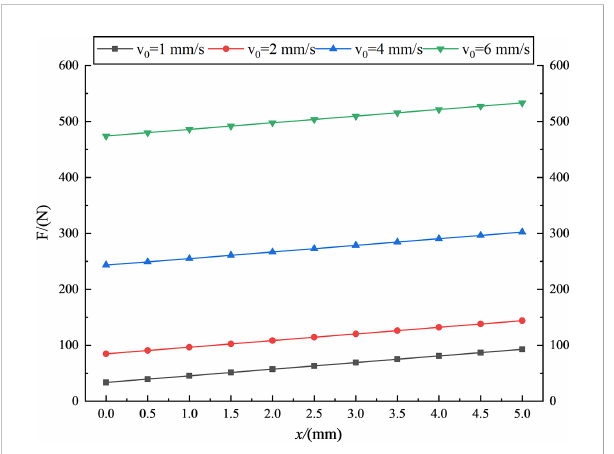
FIGURE 9 In fl uence of pressure pipe length on pressing force.